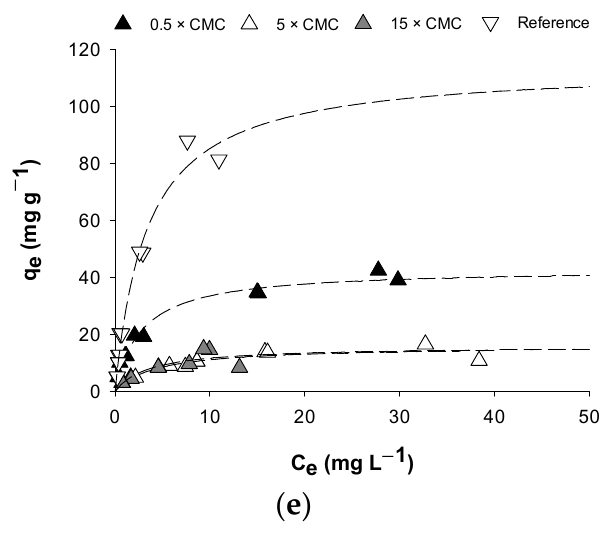
Figure 4. Isotherm curve of PCE on PWB, and surfactant solutions in different concentrations: ( a ) Table 4. Optimized parameters of the Langmuir model of PCE on PWB in the presence and in the absence of surfactants.